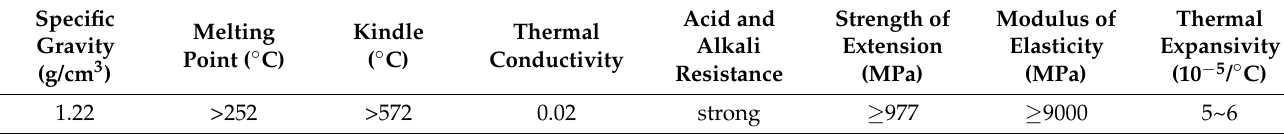
Table 1. Technical parameters of polyester fiber.